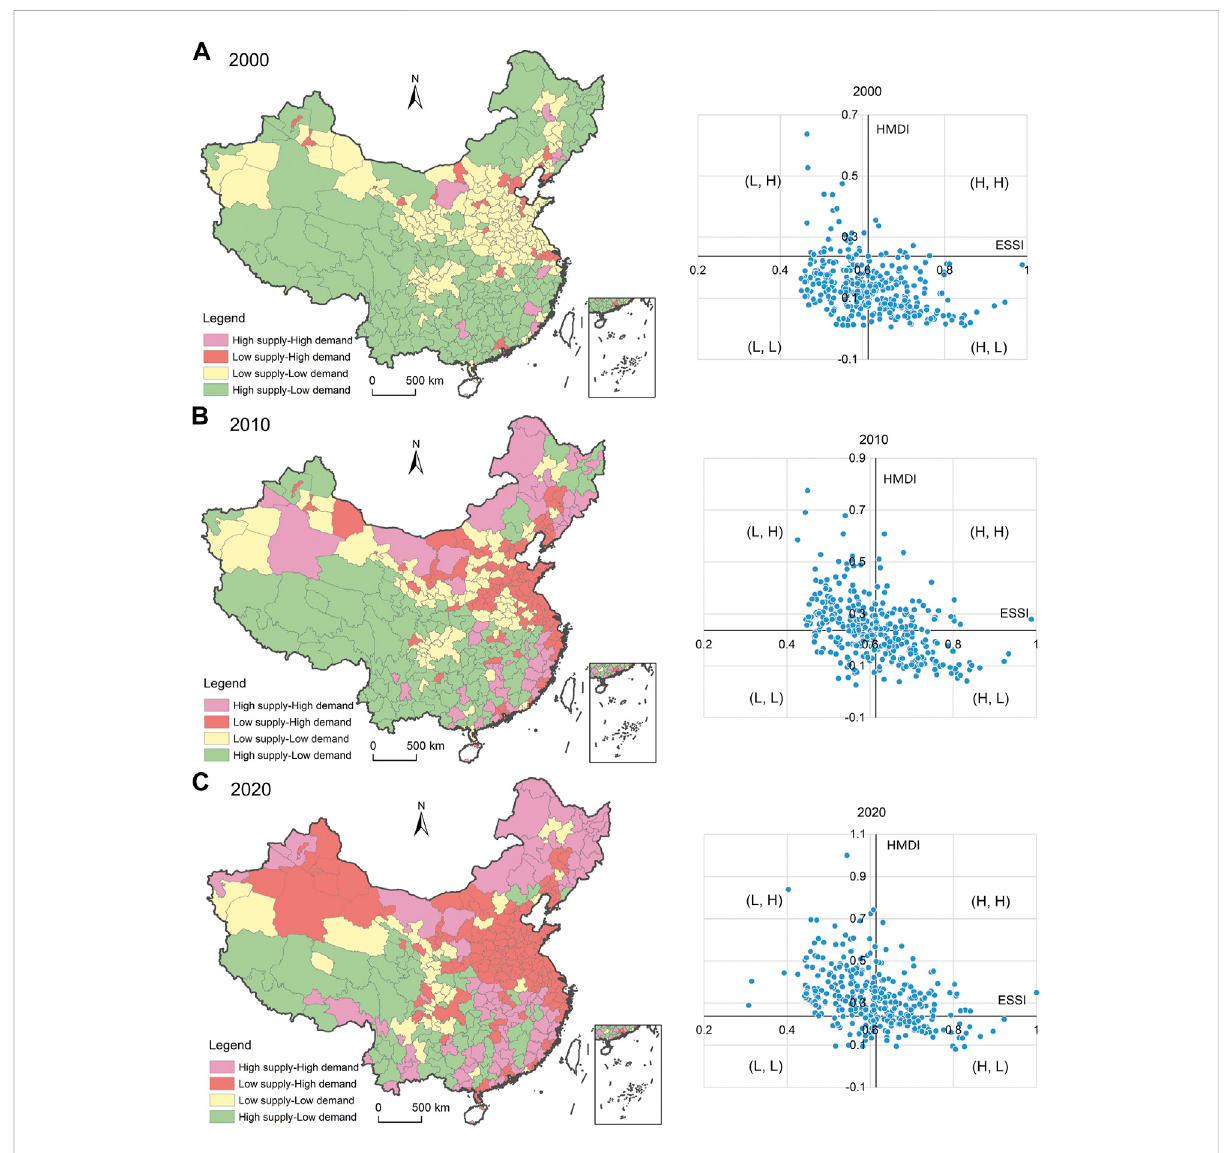
FIGURE 6 Spatial mismatches of ecosystem services supply and human